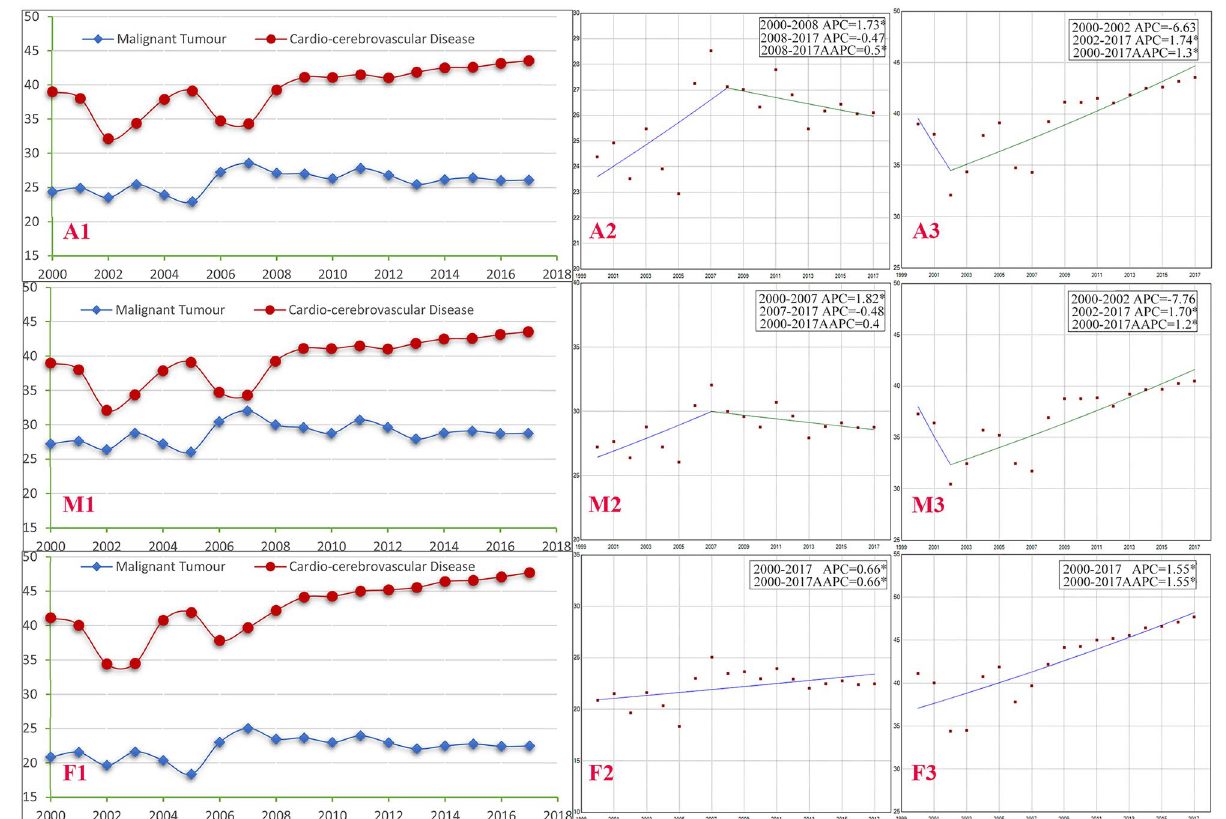
Figure 1. Comparison of trends for malignant tumor and cardio-cerebrovascular disease as causes of death in urban areas of China from 2000 to 2017. Note A all; M male; F female; 1 line chart based on raw data; 2 Joinpoints graph for malignant tumor; 3 Joinpoints graph for cardio-cerebrovascular disease; APC Annual Percent Change; AAPC Average Annual Percent Change; *Indicates that AAPC or APC is significantly different from zero at the alpha = 0.05 level. x-axis: year; y-axis: the proportion of from 2000 to 2008. In urban areas, malignant tumor-related deaths accounted for 27.12% of total deaths in 2008, and its proportion has been fluctuating at a high level from 2008 to 2017. In rural areas, even malignant tumor- related deaths only accounted for 23.07% (lower than 25.50%) of total deaths in 2017, it presented a continuing upward trend from 2008 to 2017. Based on this result, we urgently need to control its occurrence in rural areas in China, but at the same time, we should also strengthen interventions for urban populations because of their high base. In 2016, it was reported that CVD accounted for more deaths than tumor or any other disease did in China, which was the first-leading cause of death in China 12 . In 2018, National Center for Cardiovascular Diseases estimated that about 290 million patients were suffered from CVD in China, including 13 million from stroke, 11 million from coronary heart disease, 5 million from pulmonary heart disease, 4.5 million from heart fail- ure, 2.5 million from rheumatic heart disease, 2 million from congenital heart disease and 245 million from hypertension 12 . Our study indicated that the proportion of death caused by malignant tumor was higher than that caused by cerebrovascular disease and heart trouble, but lower than that caused by CVD. CVD-related deaths accounts for more than 40% of total deaths after 2010, especially in females (more than 45%), with a peak of 50.4% in rural females in 2017. Increasing aging, lifestyle changes, psychological stress, and other unhealthy behaviors have led to a continuous increase in the number of heart trouble 13 , increasing the burden of cardiovascular disease, especially the increase in cardiovascular mortality in rural areas in China. Note that the proportion of death of heart trouble is rising fastest, especially in rural areas with AAPC = 4.3%. However, the density of health-care professionals is lower in rural than urban areas in China 14 . So, strengthening the prevention and treatment of CVD under the leadership of the government is an urgent task, both in urban and rural areas. According to the Global Burden of Disease 2019 (GBD 2019) study and WHO, a total number of lives lost, is associated with three broad topics: cardiovascular, respiratory, and neonatal conditions. Respiratory diseases, especially respiratory infections, and tuberculosis; are closely related to economic development. People living in a low-income country are far more likely to die of respiratory diseases. With the development of the economy and the acceleration of urbanization in China, the proportion of death caused by respiratory diseases is decreasing, especially in rural areas with AAPC = − 3.6% from 2000 to 2017. Moreover, respiratory diseases are also closely related to air quality 15 . China has experienced a severe deterioration in air quality over the past several years.